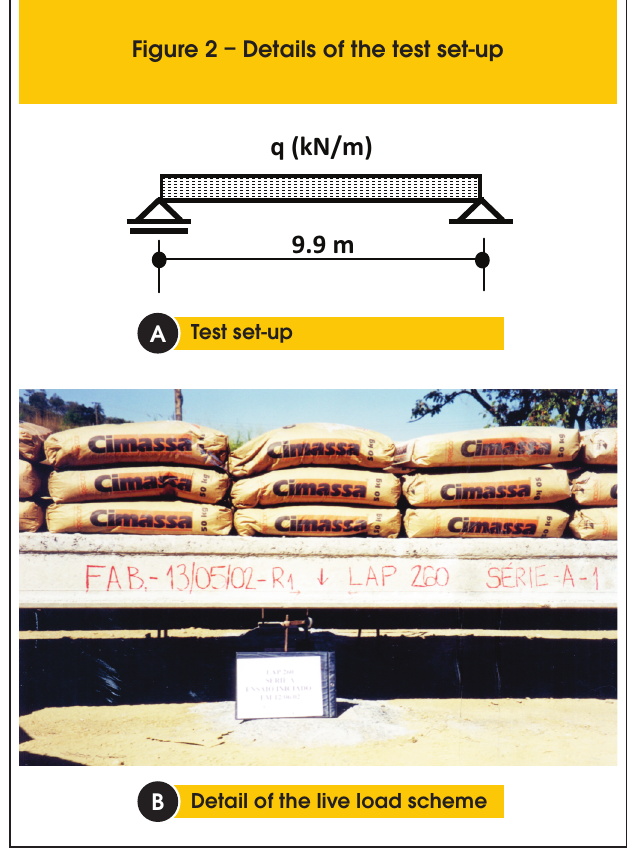
Figure 2 – Details of the test